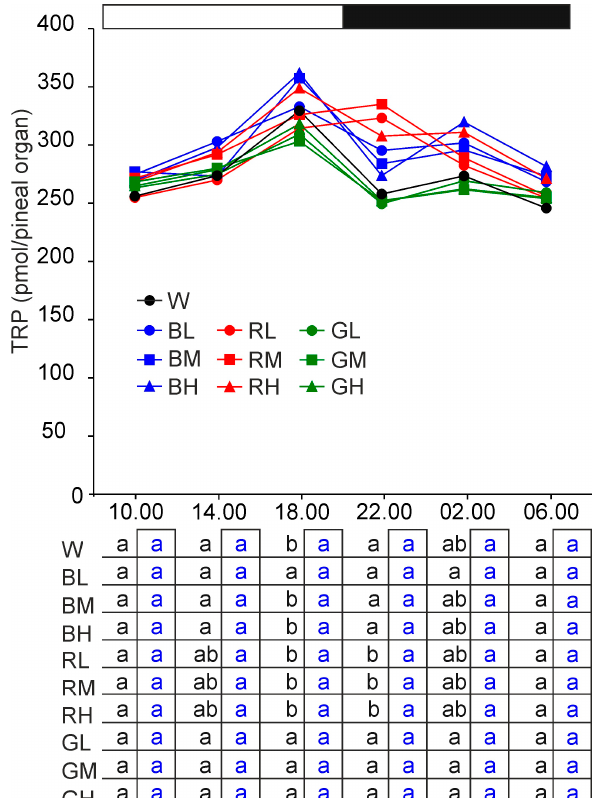
Figure 2. Content (means) of tryptophan (TRP) in the pineal organs of turkeys kept under white light (W) with intensity of 16 1×, blue light with intensities of 16 lx (BL), 32 lx (BM), and 64 lx (BH), red light with intensities of 16 lx (RL), 32 lx (RM), and 64 lx (RH), green light with intensities of 16 lx (GL), 32 lx (GM), and 64 lx (GH) during the photophase. For further explanation, see Figure 1.